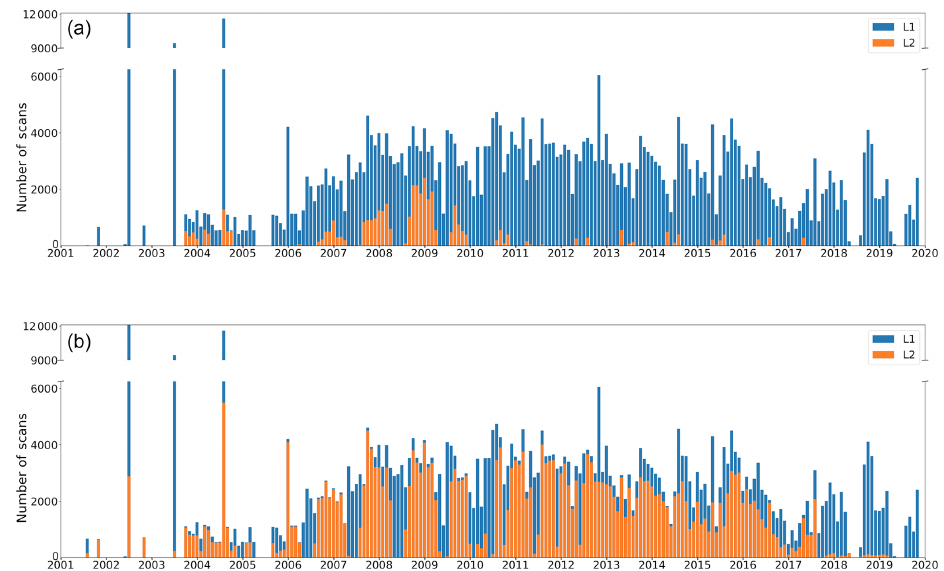
Figure 7. Number of L1 and L2 scans by month for FM14, FM22 and FM24 altogether, before (a) and after (b) the application of the correction algorithm. The ticks on the x axis correspond to 1 January for each year. This figure gives an overview of how much data could be